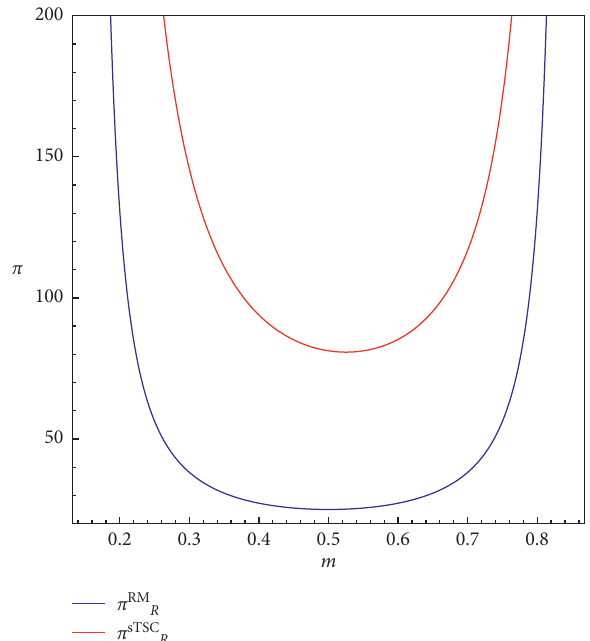
Figure 3: Comparison of the retailer’s profit for the manufacturer and centralized rebates with manufacturer’s offering r sTSC ∗ .